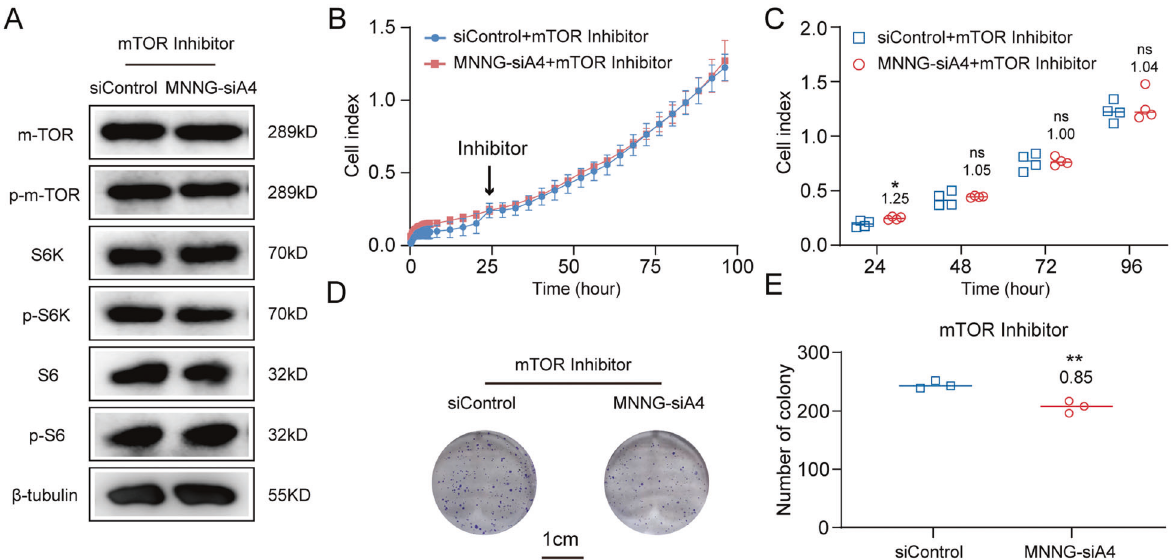
Fig. 6 A mTOR inhibitor abolishes the elevated growth of MNNG-siA4 cells. A Western blot detection of proteins in the mTOR signaling pathway showed that activation of this pathway in MNNG-siA4 cells was reduced by mTOR inhibitor. B In vitro measurement of cell attachment and cell proliferation in the MNNG-siA4 and control cell lines with 0.2 μ M mTOR inhibitor treatment. C Cell index at 24, 48, 72, and 96 h with 0.2 μ M mTOR inhibitor treatment. Mean ± SD ( N = 4, ns p > 0.05, * p < 0.05, vs. the control group). D Representative images of colony formation assays of the MNNG-siA4 and control cells after 0.2 μ M mTOR inhibitor treatment. E Quantitation of colony counts with 0.2 μ M mTOR inhibitor treatment. Mean ± SD ( N = 3, ** p < 0.01 vs. the control